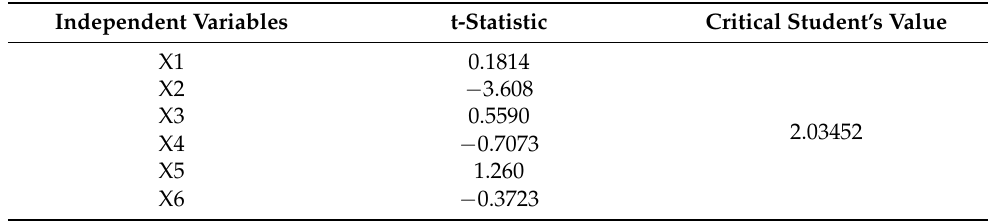
Table 14. Checking the significance of regression